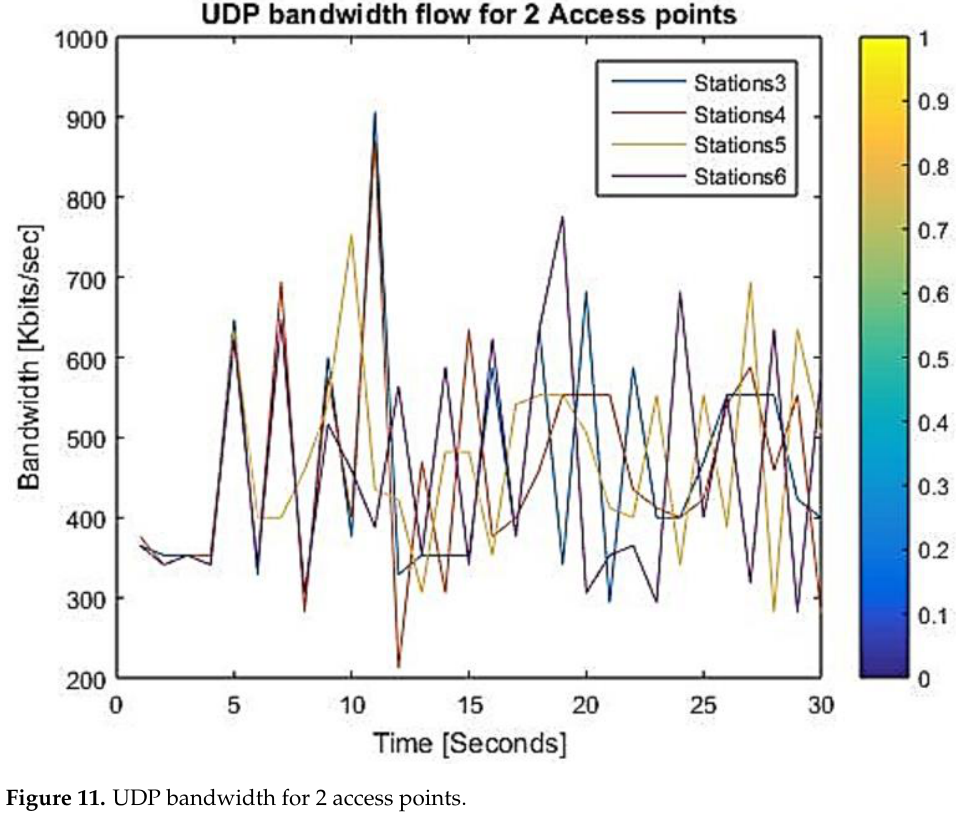
Figure 11. UDP bandwidth for 2 access points.